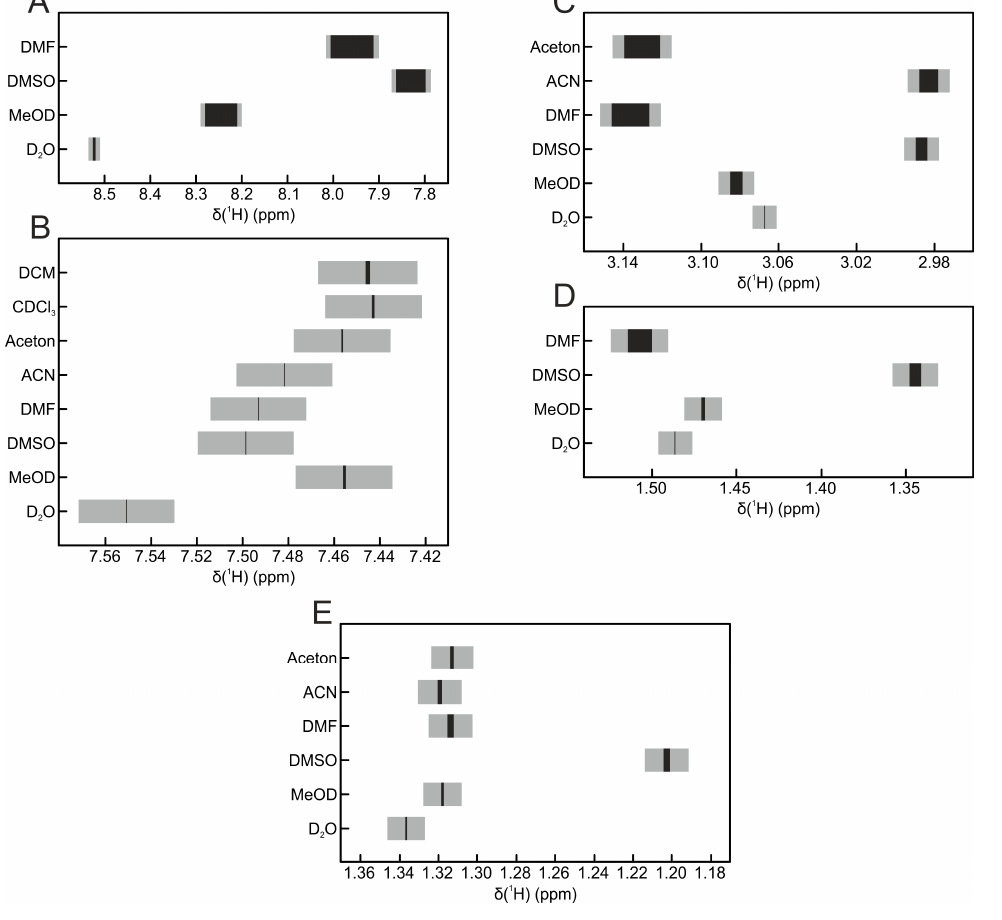
Figure 3. Signal positions of selected metabolites. The black bar represents the center of the signal and its shift over all replicates. The grey box represents the area of the whole signal over all replicates. ( A ) histidine; ( B ) hippurate; ( C ) creatinine; ( D ) alanine; ( E ) lactate.